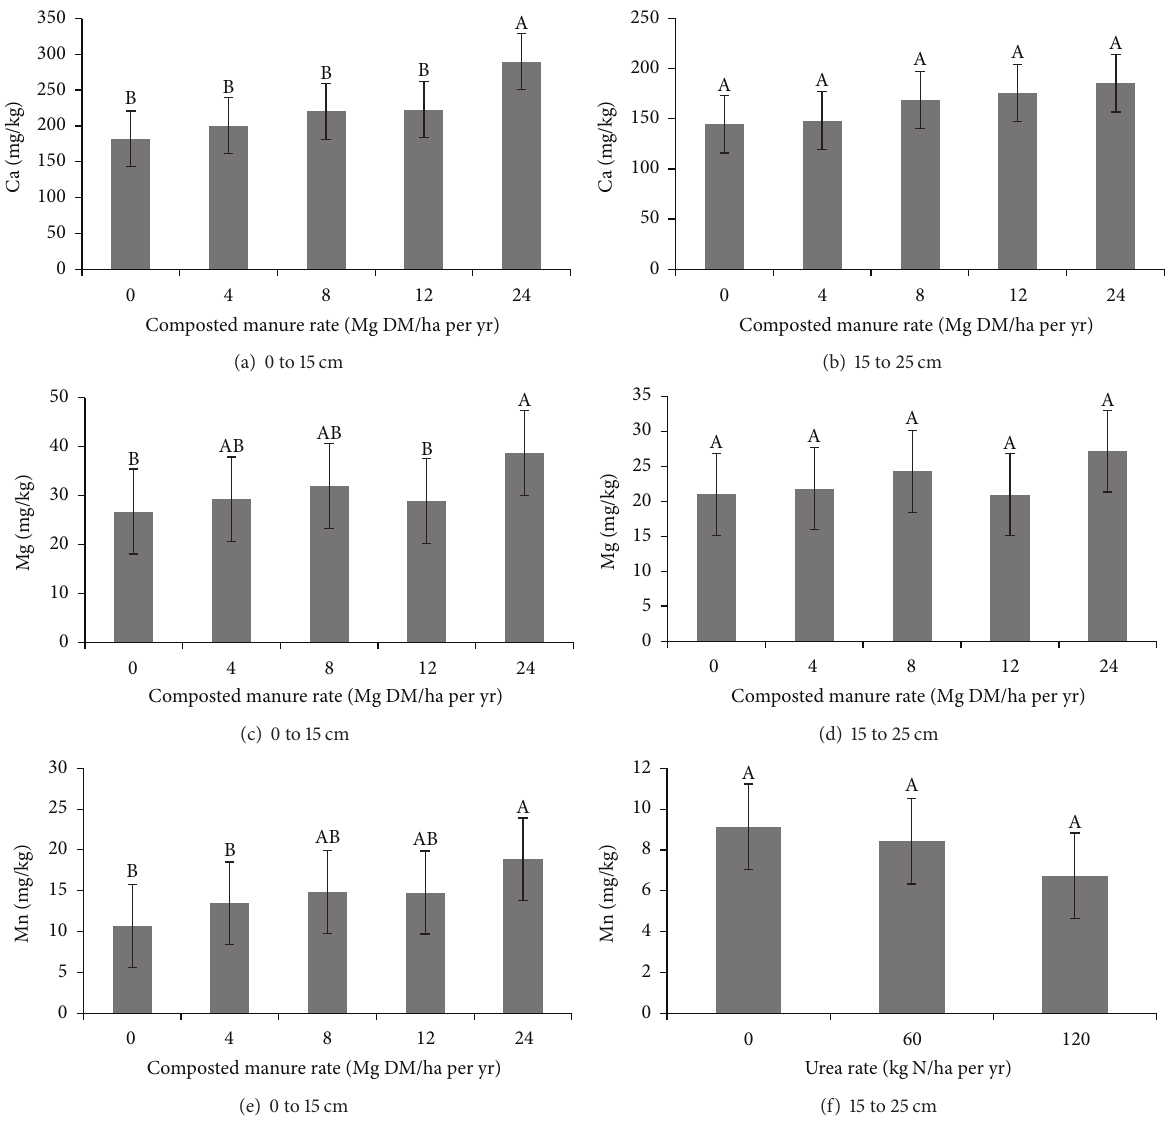
Figure 2: Postexperiment soil Ca least squares means for composted manure rates in the 0 to 15cm ((a), 𝑃 < 0.0001 ) and 15 to 25 cm strata ((b), 𝑃 = 0.1873 ), Mg least squares means in the 0 to 15cm ((c), 𝑃 = 0.0015 ) and 15 to 25 cm ((d), 𝑃 = 0.0542 ) strata, and Mn least squares means for compost treatments in the 0 to 15 cm stratum ((e), 𝑃 = 0.0002 ) and for urea treatments in the 15 to 25 cm stratum ((f), 𝑃 = 0.2015 ). Error bars are ± 1 SE of the mean. Bars connected by the same letter are not significantly different ( 𝑃 ≤ 0.05). Models contain preexperiment soil fertility factors (Table